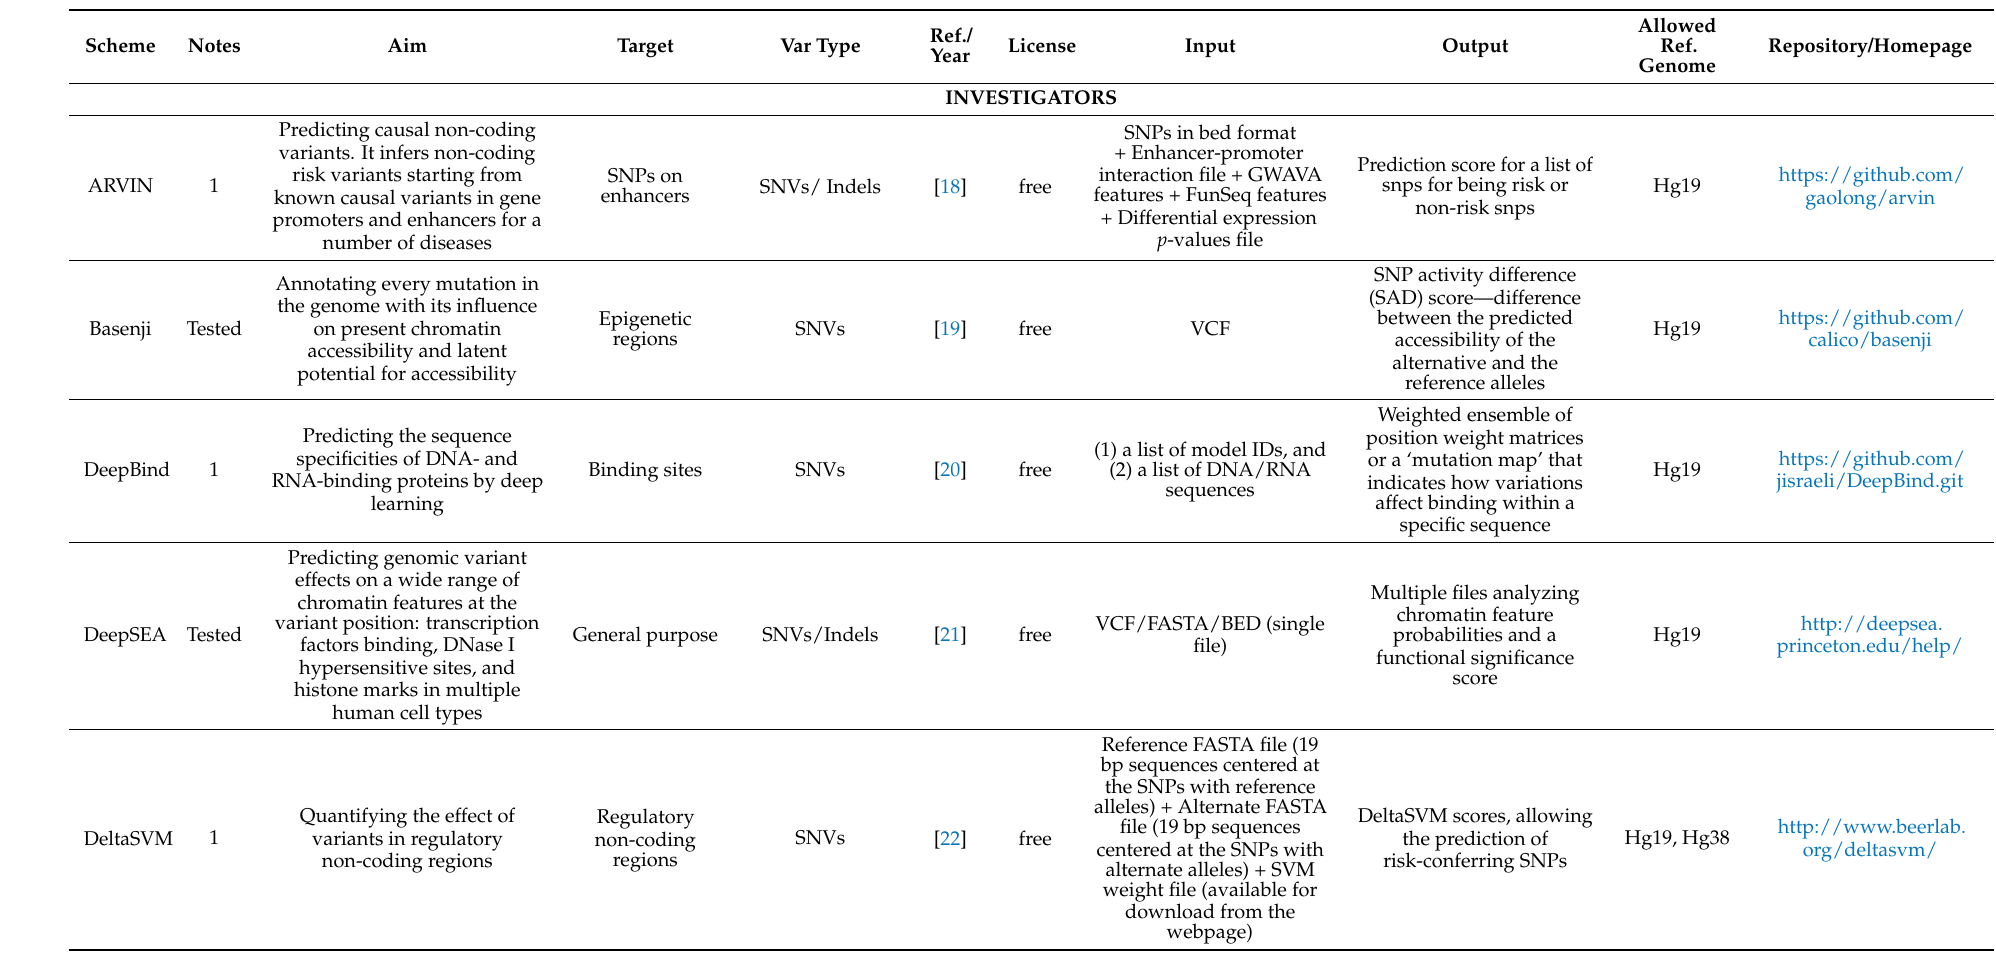
Table 2. List of the tools considered for non-coding variant